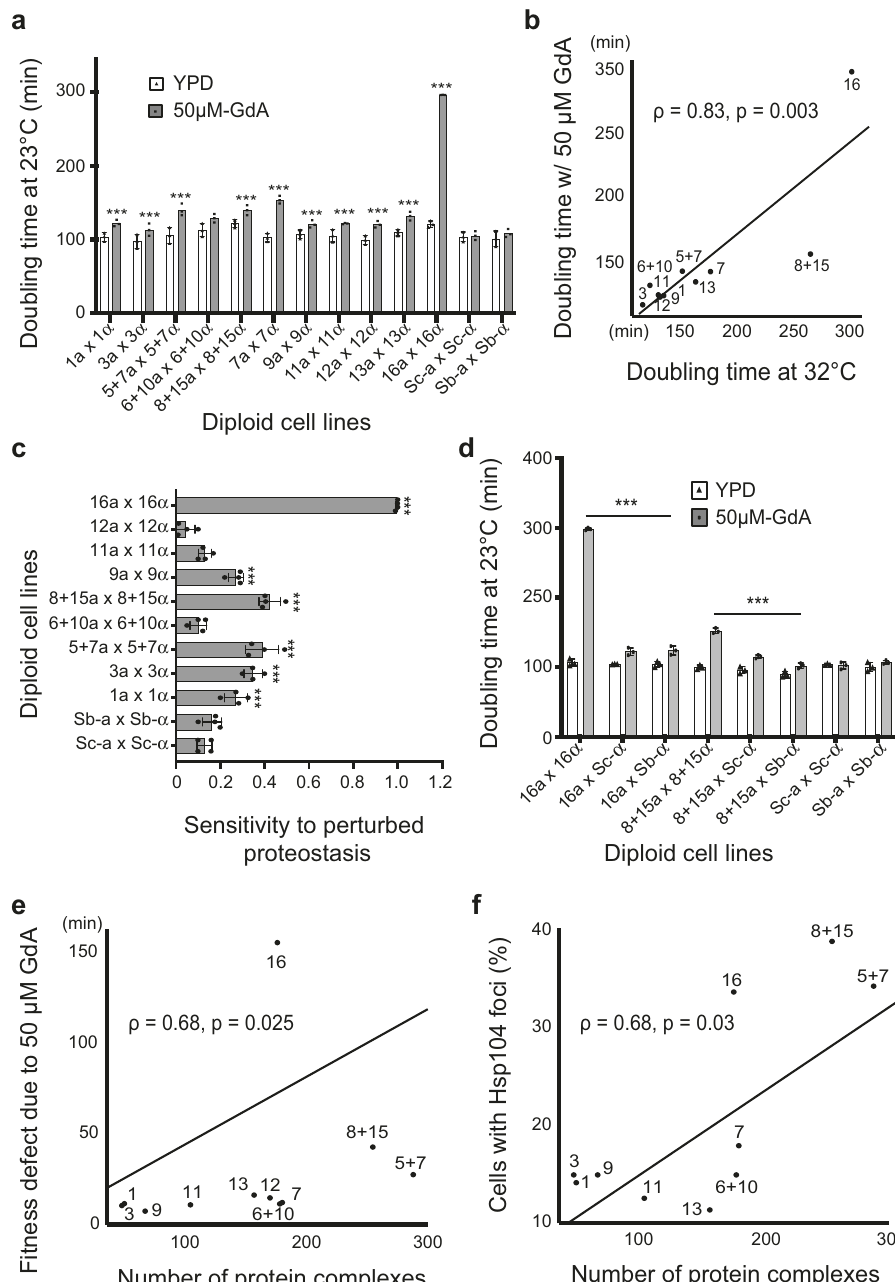
Fig.2|Proteotoxicstress-inducedincompatibilityleadstomitoticandmeiotic defects.a Growthratesofdiploidreplacementlinesaresigni fi